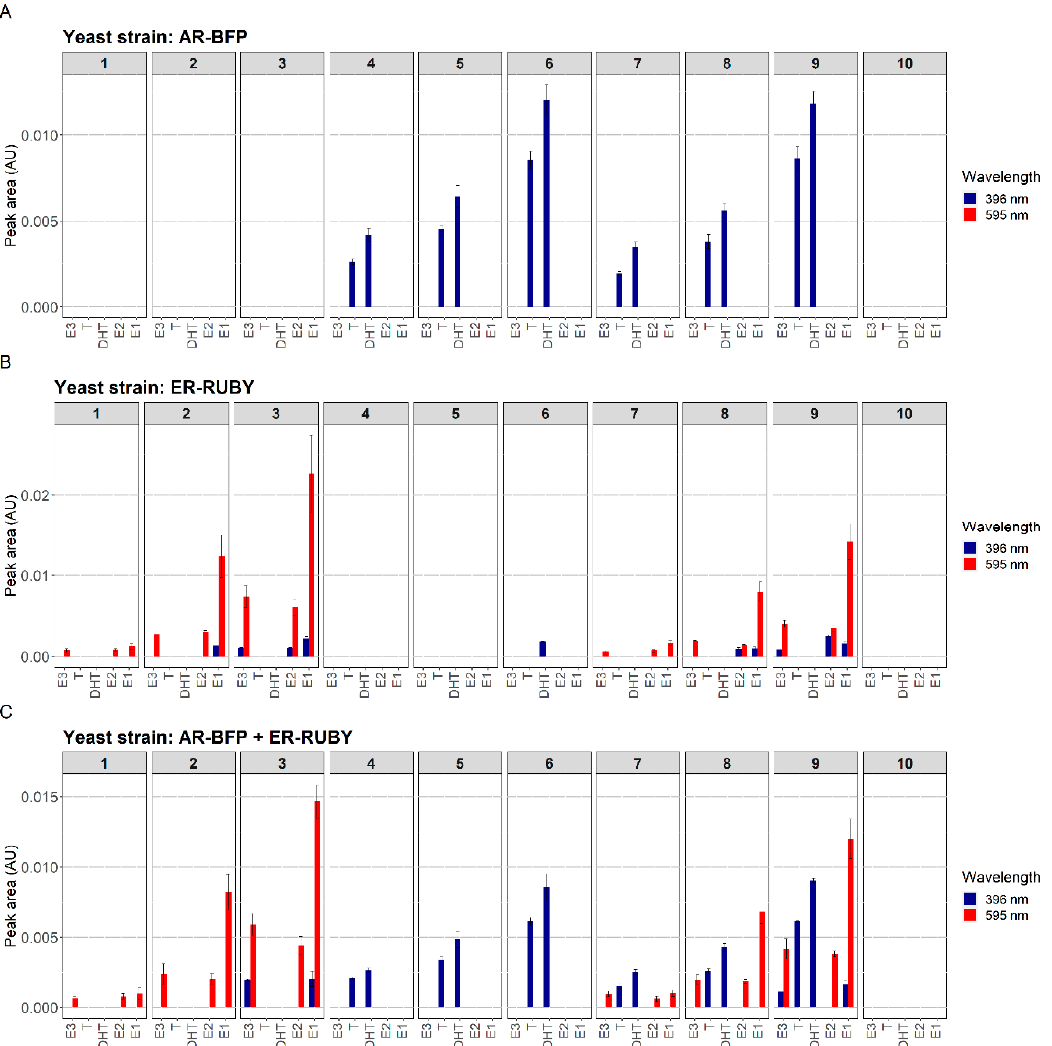
Figure 8. Multi-effect detection of chromatographically separated model compound mixtures by strain AR-BFP ( A ), strain ER-Ruby, ( B ) and both strains together ( C ). The HPTLC plates with the sprayed-on sensor cells were incubated for 18 h at 30 °C, following which fluorescence was scanned at λ = 396 nm and λ = 525 nm. Fluorescence intensities are presented in arbitrary units (AU). The estrogen mixture, separated on tracks 1–3 and 7–9, was composed of E1 (0.01 ng, 0.05 ng and 0.1 ng), E2 (0.005 ng, 0.01 ng and 0.02 ng), and E3 (0.5 ng, 1 ng and 2 ng). The androgen mixture, separated on tracks 4–6 and 7–9, was composed of testosterone (T; 0.5 ng, 1 ng and 5 ng) and DHT (0.5 ng, 1 ng and 5 ng). Ethanol served as blank on track 10. A two-step chromatographic development was performed, with 100% methanol for the first 20 mm, and an ethyl acetate/n-hexane 1:1 mixture for the next 70 mm. Table 2. Limit of detection (LOD), limit of quantification (LOQ) and Rf values calculated for the ER– Ruby and AR-BFP sensor strains in response to HPTLC-separated reference compounds. Single Strain Both Strains Rf Values